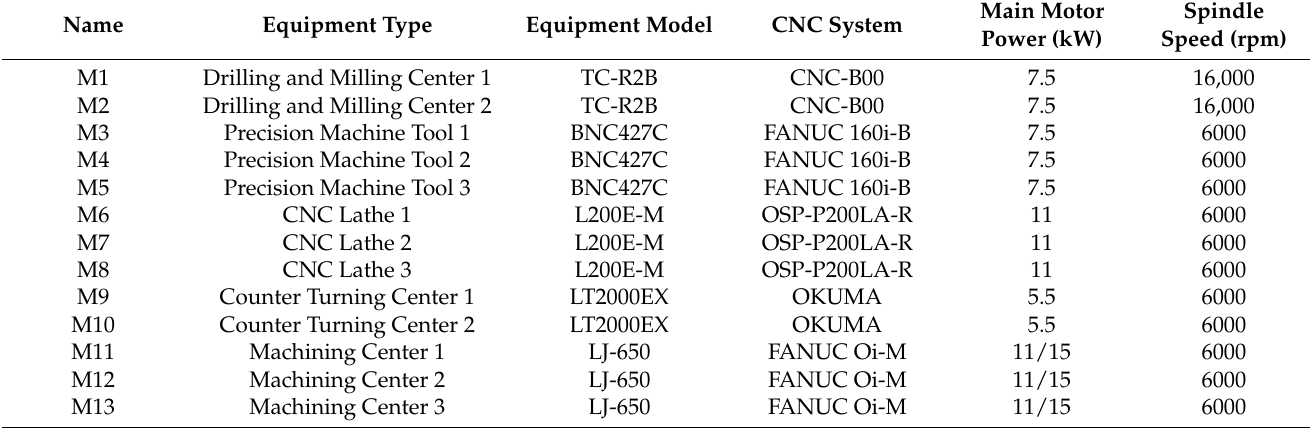
Table 4. Processing machine